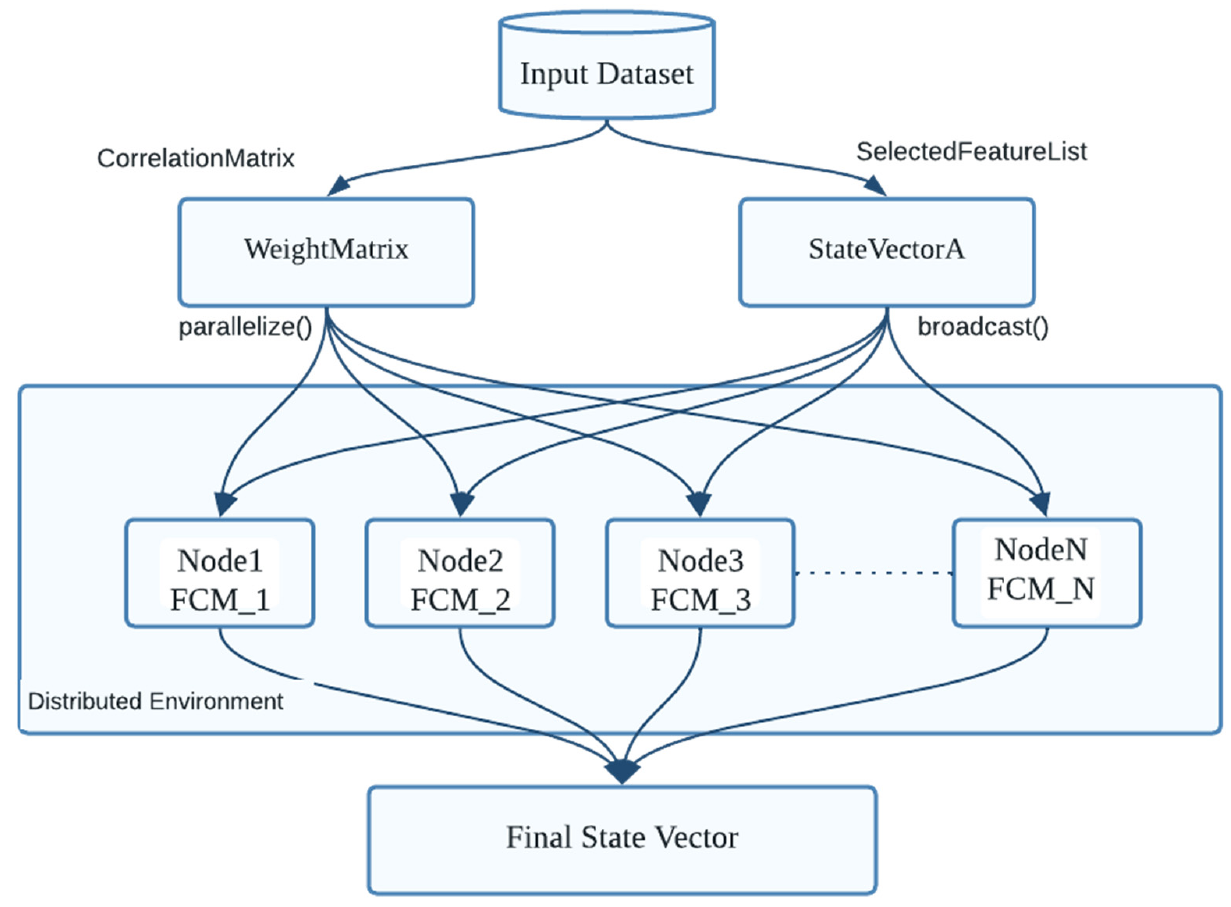
Figure 2. Distributed FCM learning.